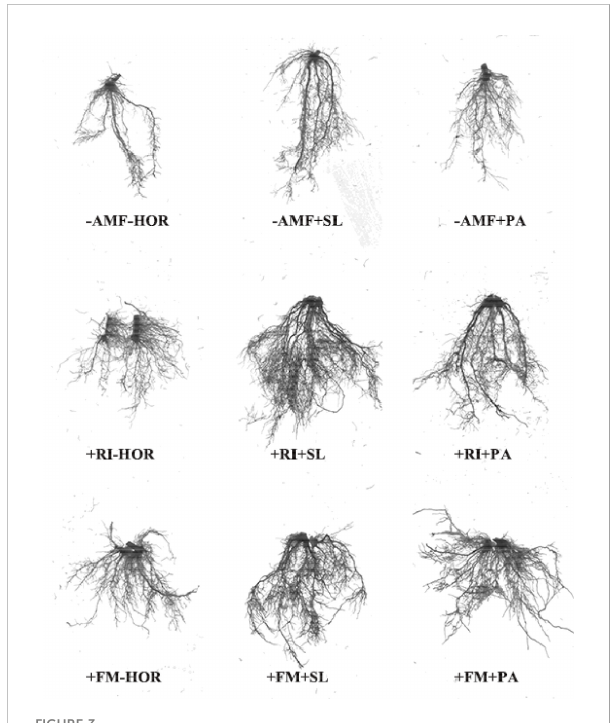
FIGURE 3 Root system architecture responses of tea cutting seedings to different